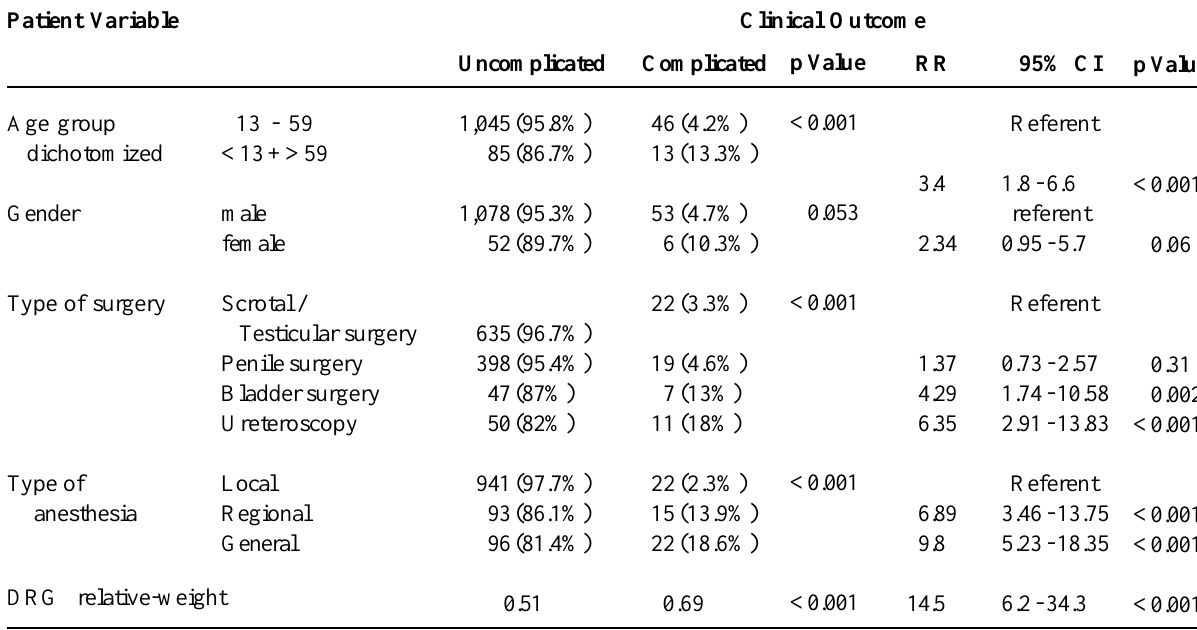
Table 4 – Results of the univariate risk factor